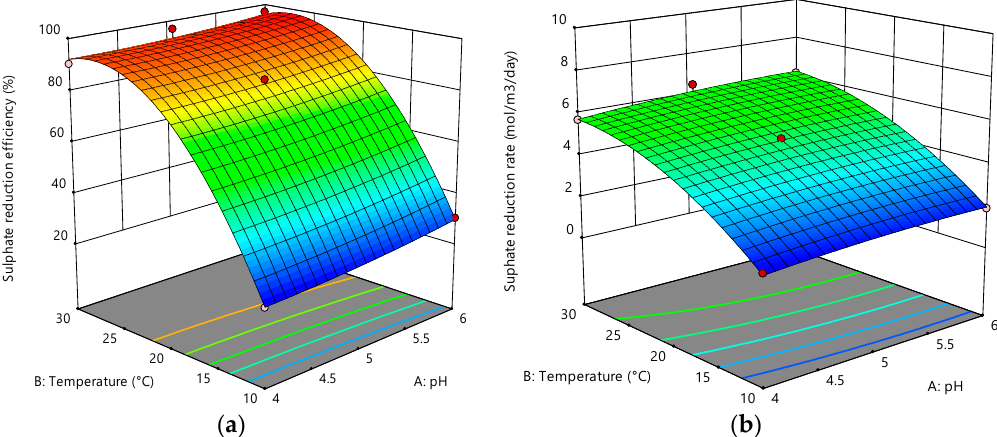
Figure 10. Interactive effects between temperature and pH on ( a ) sulphate reduction efficiency and ( b ) sulphate reduction rate.